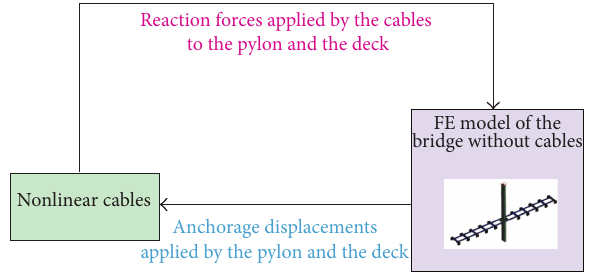
Figure 10: Principle of coupling between the FE model of the bridge and the nonlinear